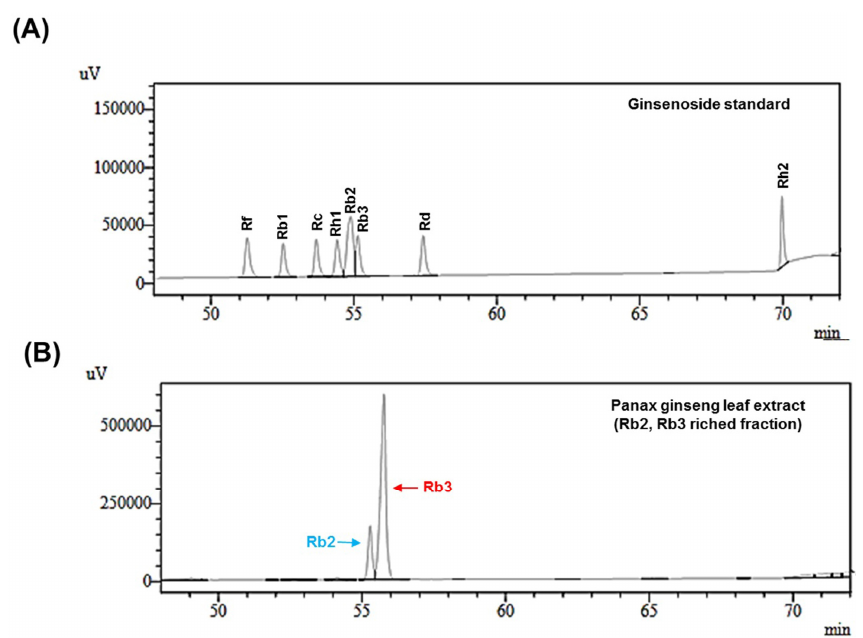
Figure 1. Phytochemical analysis of Panax ginseng leaf extract. ( A ) Typical HPLC chromatogram of 12 ginsenoside standards analyzed at 203 nm; ( B ) Quantitative analysis of ginsenosides in Panax ginseng leaf extract.